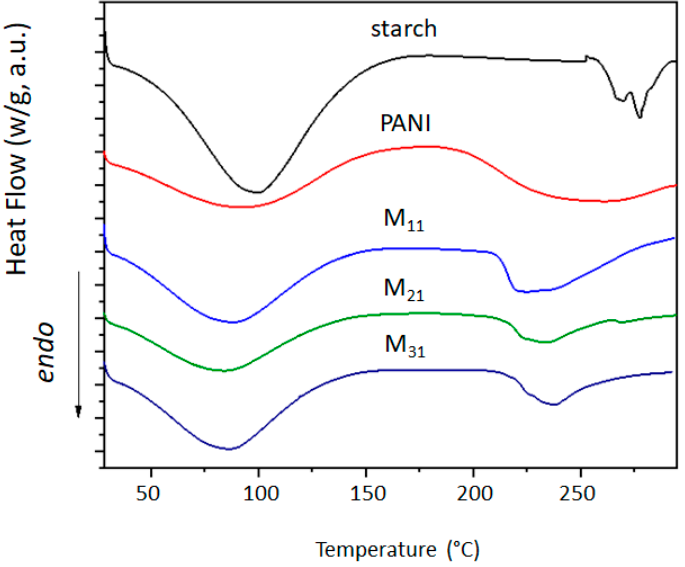
Figure 7. DSC thermograms of starch, PANI, and PANI–starch biocomposites. Table 7. Data obtained from DSC thermograms of starch, PANI, and PANI–starch biocomposites.